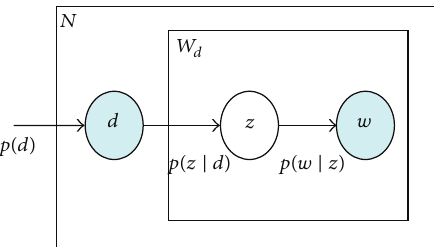
Figure 2: Graph model of pLSA. Nodes represent random variables. Shaded nodes are observed variables and unshaded ones are unseen variables. The plates stand for repetitions.